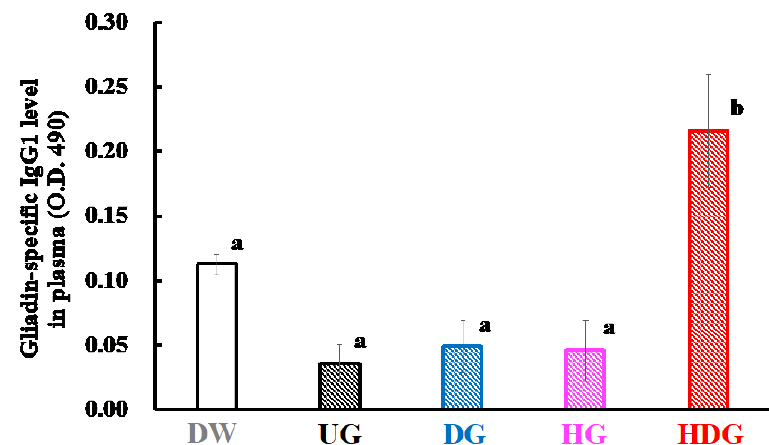
Figure 8. Gliadin-specific IgG1 level in the plasma of mice after intraperitoneal challenge of gliadin followed by cutaneous sensitization with the corresponding gliadin. Values with different letters are significantly different at p < 0.05 based on the Tukey–Kramer test. Each value is the mean of eight experiments with SE shown as a vertical bar.